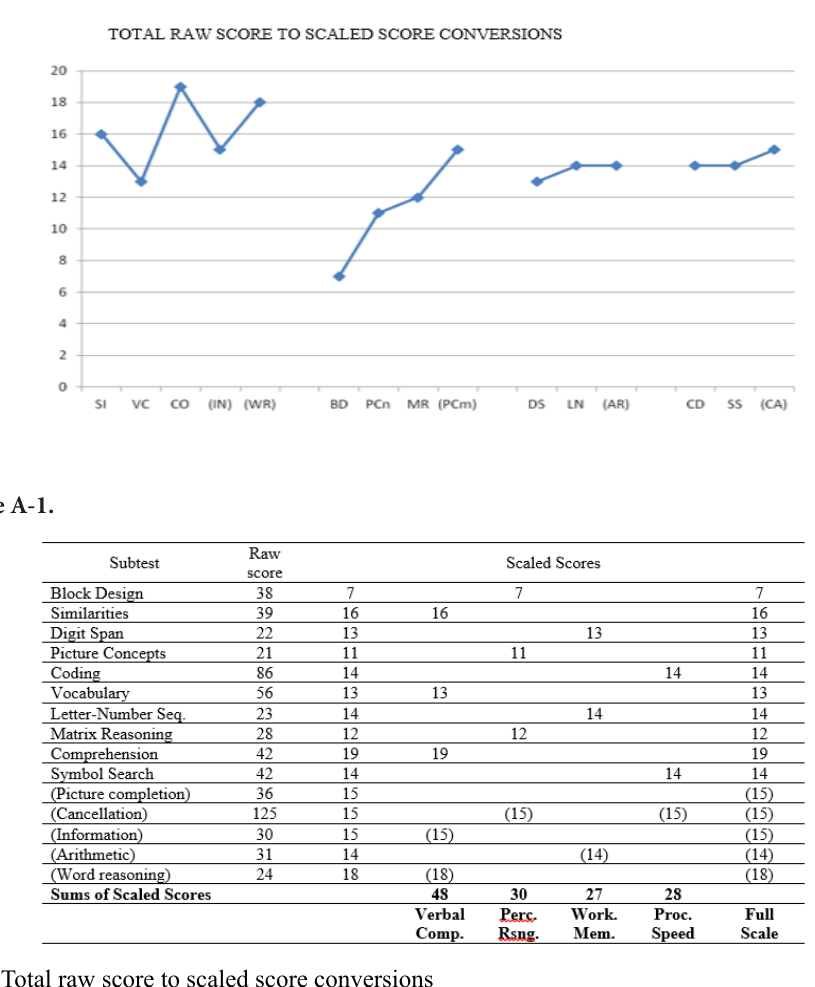
Fig. 1. Total raw score to scaled score conversions